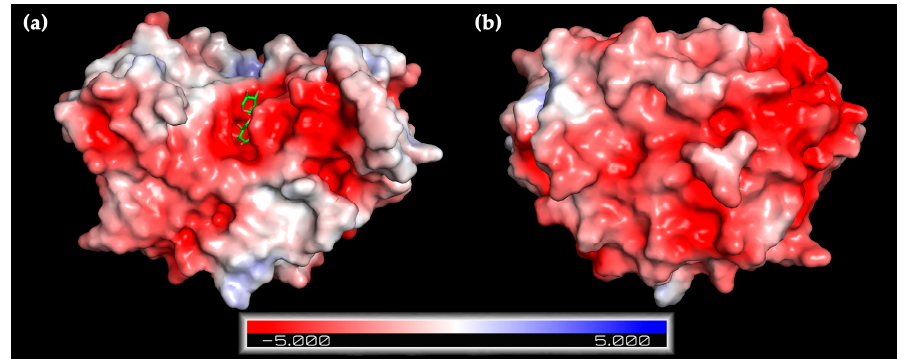
Figure 4. Predicted electrostatic potentials on the surface of XynRA2 catalytic domain from ( a ) top and ( b ) bottom views. The ligand (xylobiose) is bound at the catalytic binding pocket of XynRA2 as indicated in ( a ). Red and blue indicate negative and positive electrostatic potentials respectively.